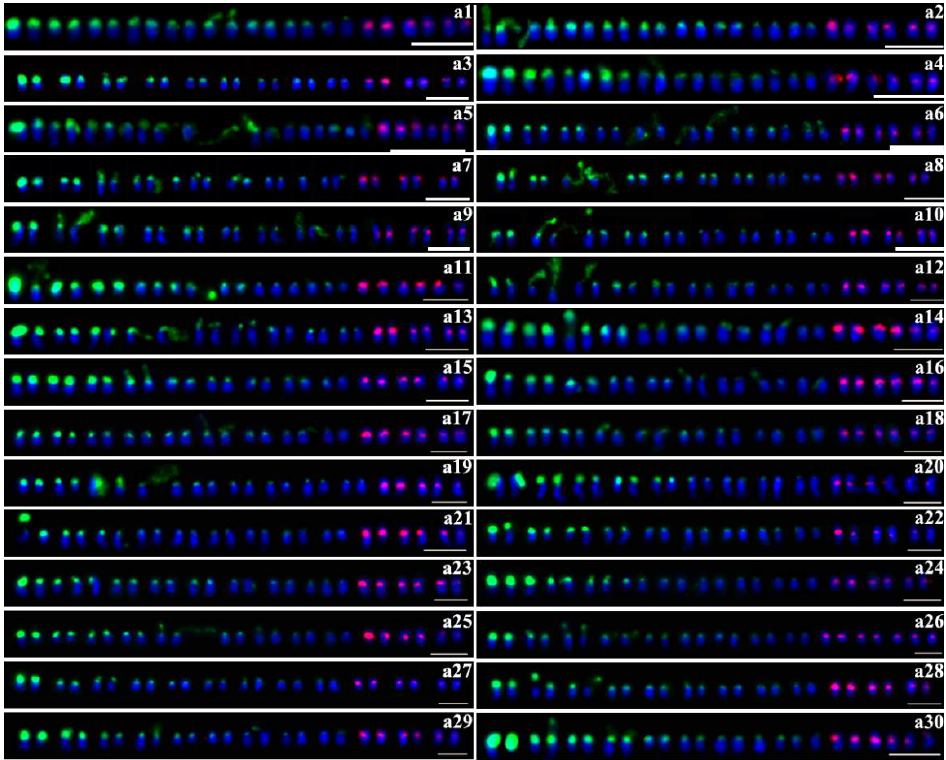
Figure 1. Distribution of 45S (green) and 5S (red) rDNA sites detected by FISH (fluorescence in situ hybridization) with the number of 45S rDNA is 18. a1: Neiyuzi 2; a2: Qinzishu 2; a3: Longzishu 6; a4: